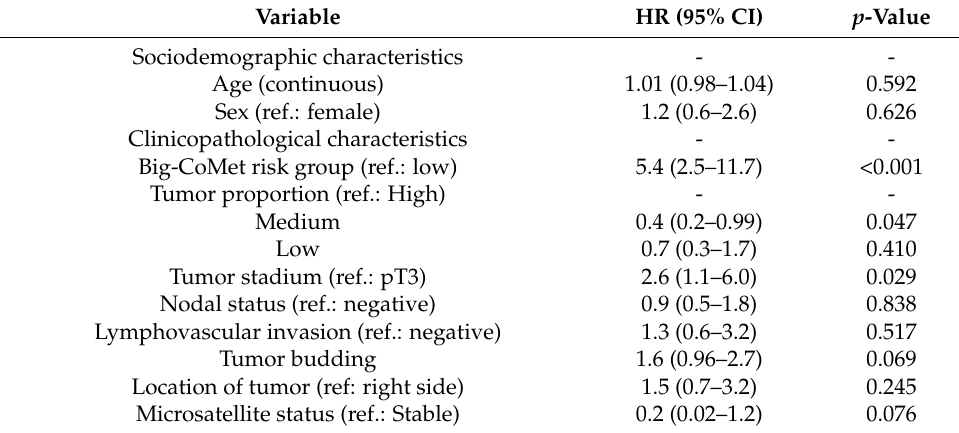
Table 2. Multivariable Cox regression for occurrence of metastasis.